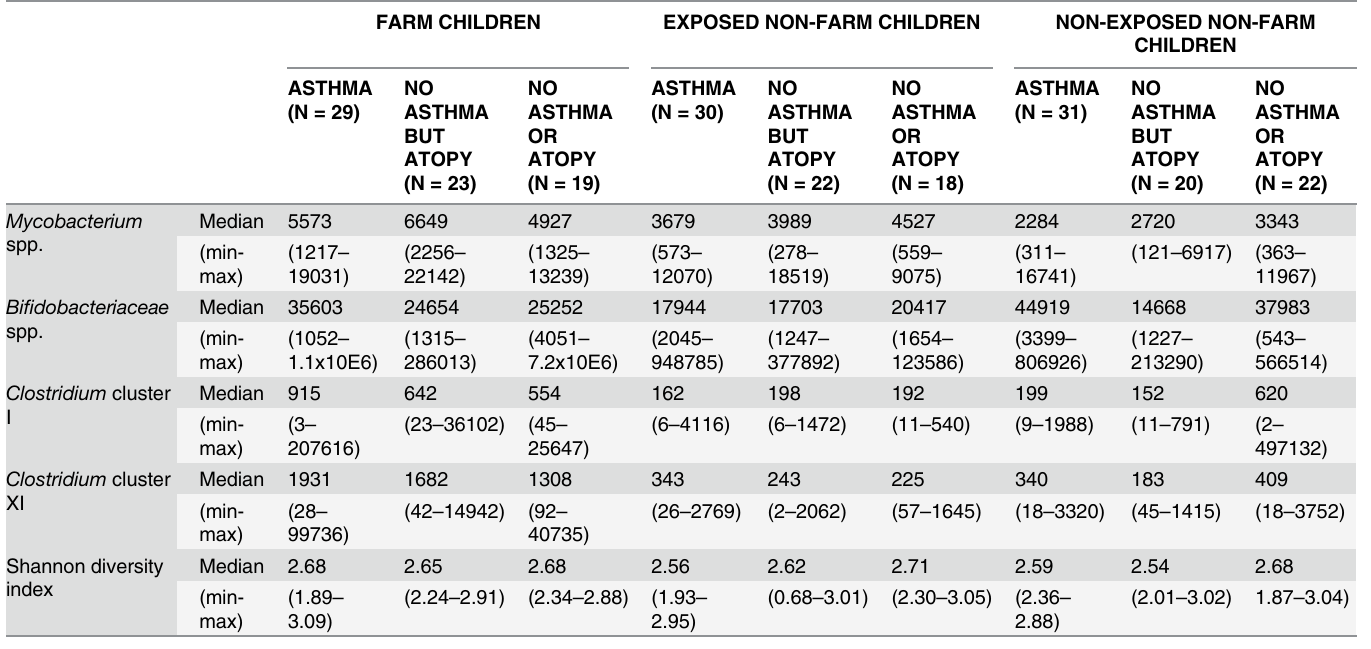
Table 4. Levels of microbes detected using qPCR (cells/mg dust) and diversity metrics in three exposure strata stratified by health outcomes.